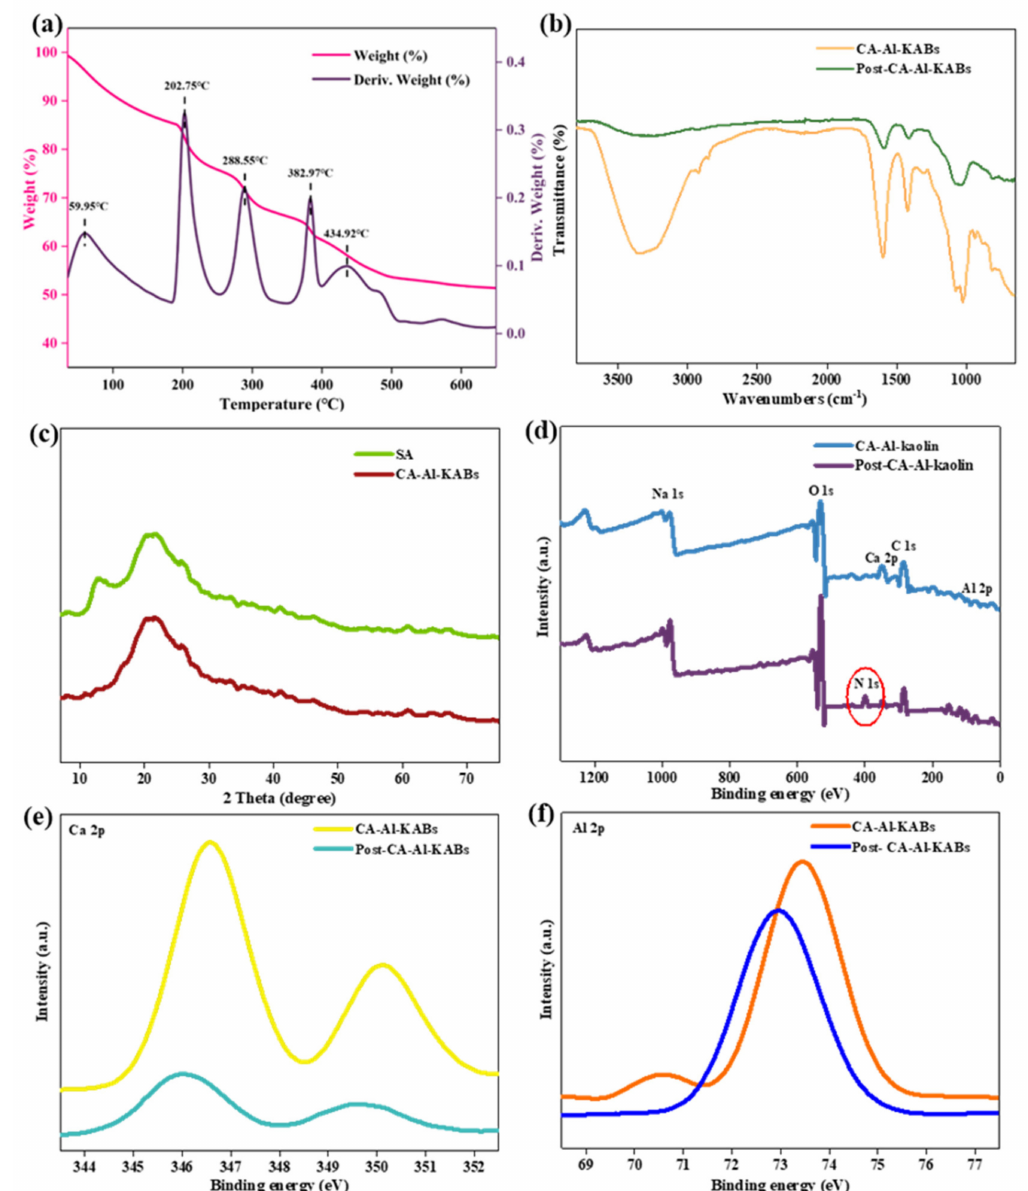
Figure 3. ( a ) TG (thermogravimetric) analysis of CA-Al-KABs, ( b ) FT-IR spectra of CA-Al-KABs before and after CIP (ciprofloxacin) adsorption, ( c ) XRD (X-ray di ff raction) patterns of SA and CA-Al-KABs, ( d ) XPS (X-ray spectroscopy) spectra of wide scan, ( e ) Ca 2p spectra, ( f ) Al 2p